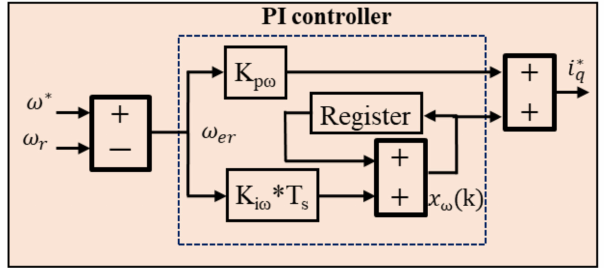
Figure 3. Xilinx system generator (XSG)-based design of the speed control